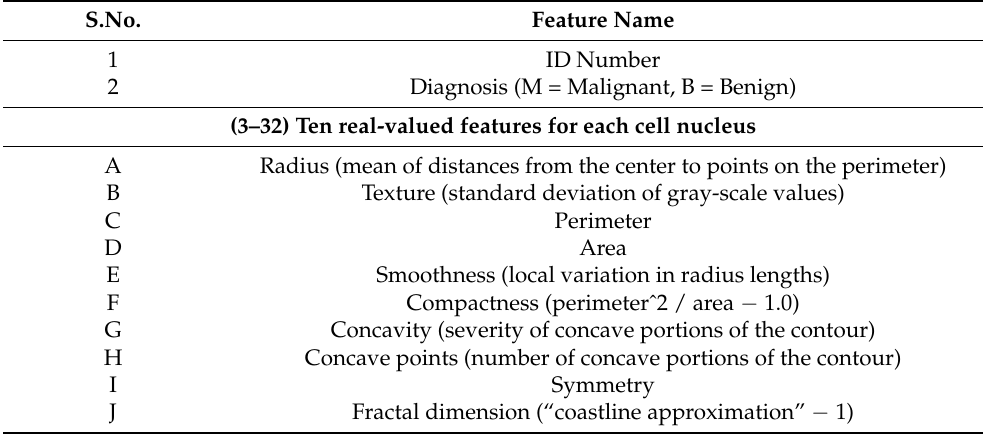
Table 1. Description of dataset